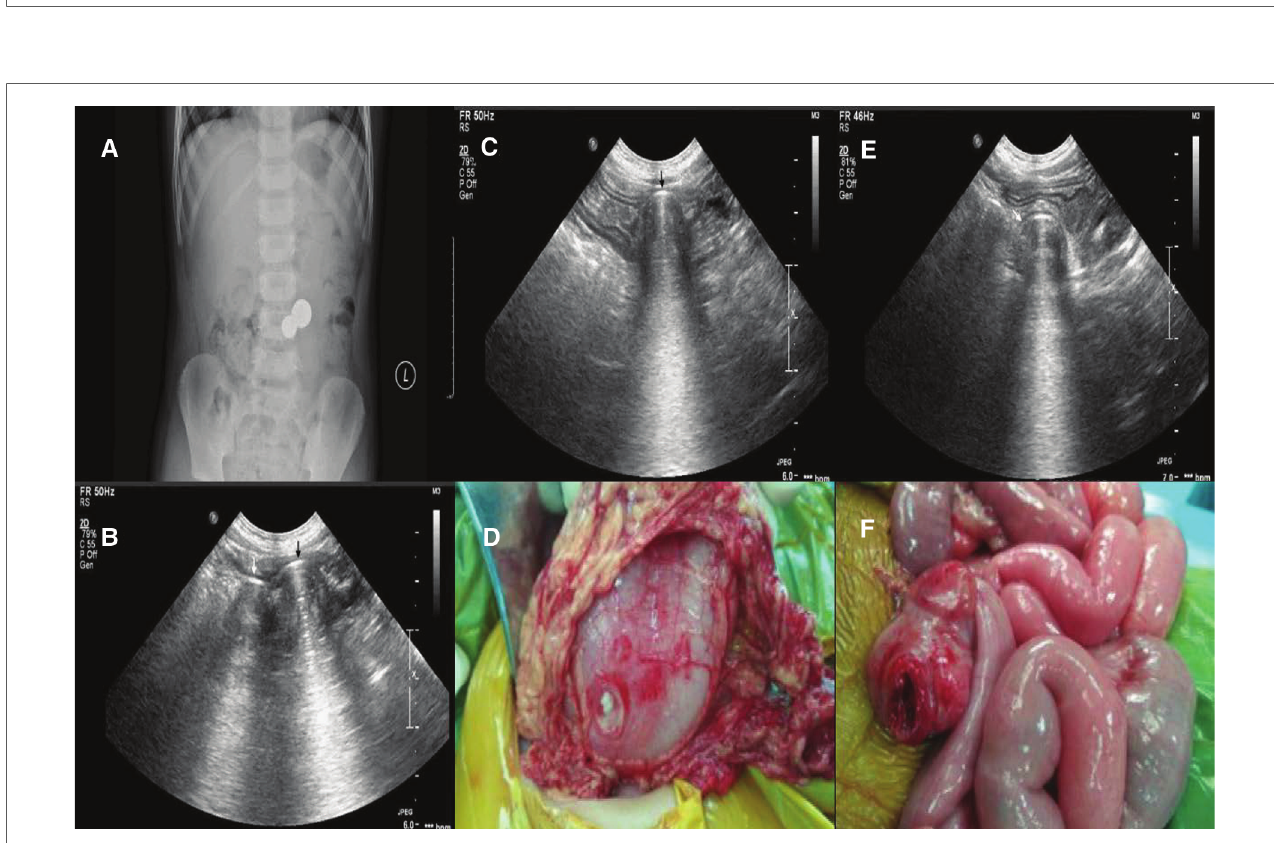
FIGURE 6 Multiple magnets in the gastrointestinal of a 6-year-old boy. The plain fi lm indicated two magnets attracted together ( A ), as indicated by the sonogram. ( B ) The sonogram revealed one magnet (black arrow) in the stomach ( C ) and the other magnet (white arrow) in the colon. ( E ) This indicates wall entrapment, which was con fi rmed by surgery. Perforation of the stomach ( D ) and colon ( F ) were found during